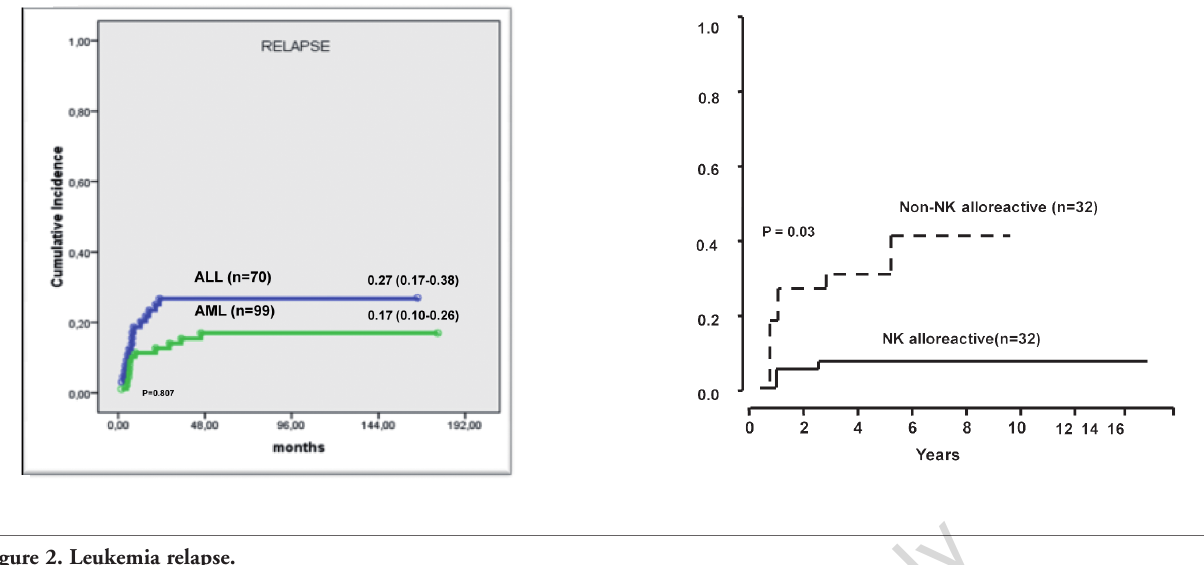
mortality.Figure 2. Leukemia